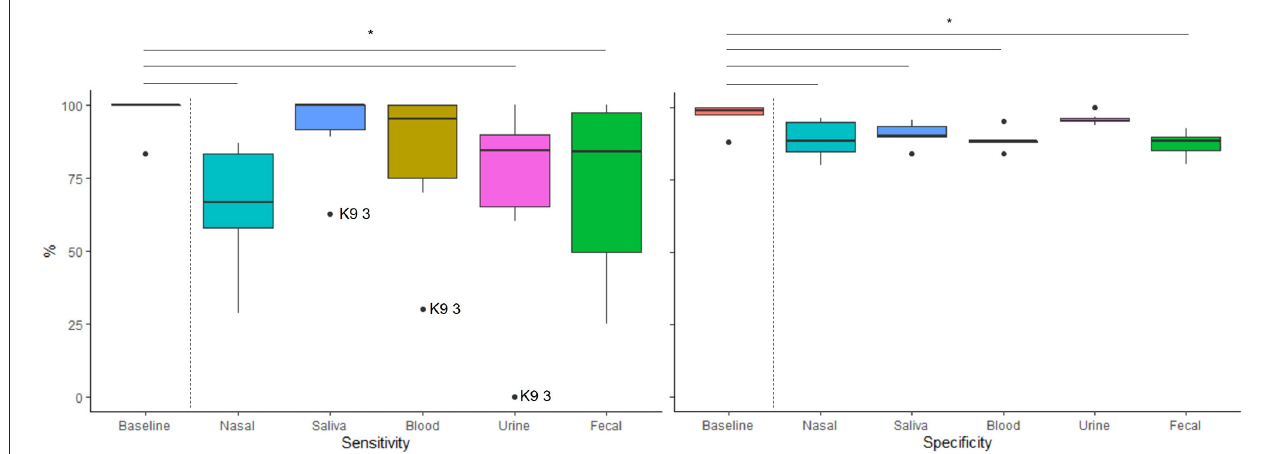
FIGURE 3 | Distribution of canine ( n = 6) sensitivity and specificity for each target (Culture, Nasal, Saliva, Blood, Urine and Feces). Horizontal lines inside boxes represent medians, boxes represent the interquartile range (IQR), and whiskers represent the range of values within 1.5 X IQR. Dots represent individual dogs that were determined outliers (either less than the first quartile - 1.5 X IQR or greater than the third quartile + 1.5 X IQR. Horizontal bars above the graph show significant differences in performance between baseline and sample tested.